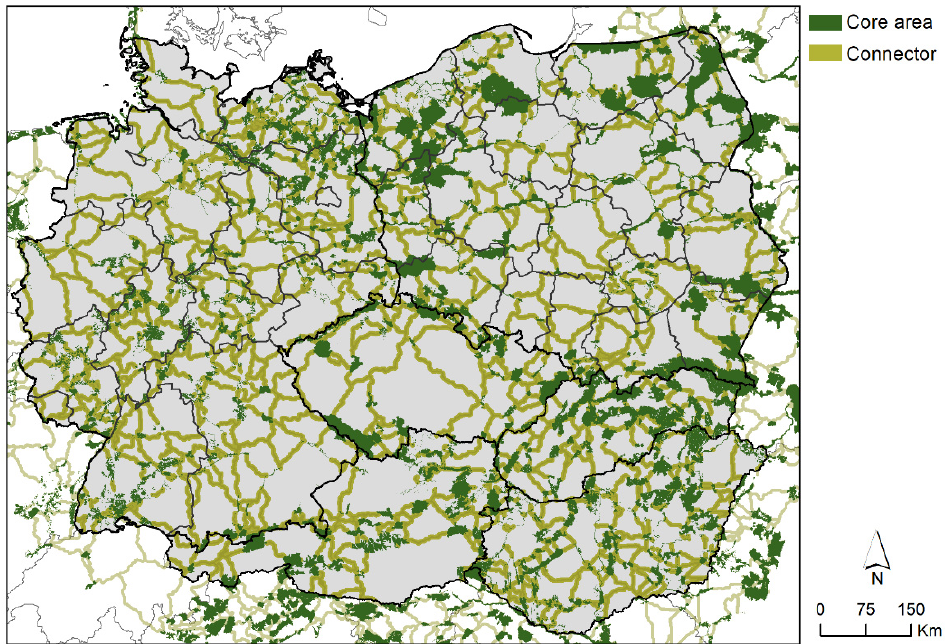
Figure 3. Proposed green infrastructure network, delineated as a set of corridors between core areas (N2k sites).